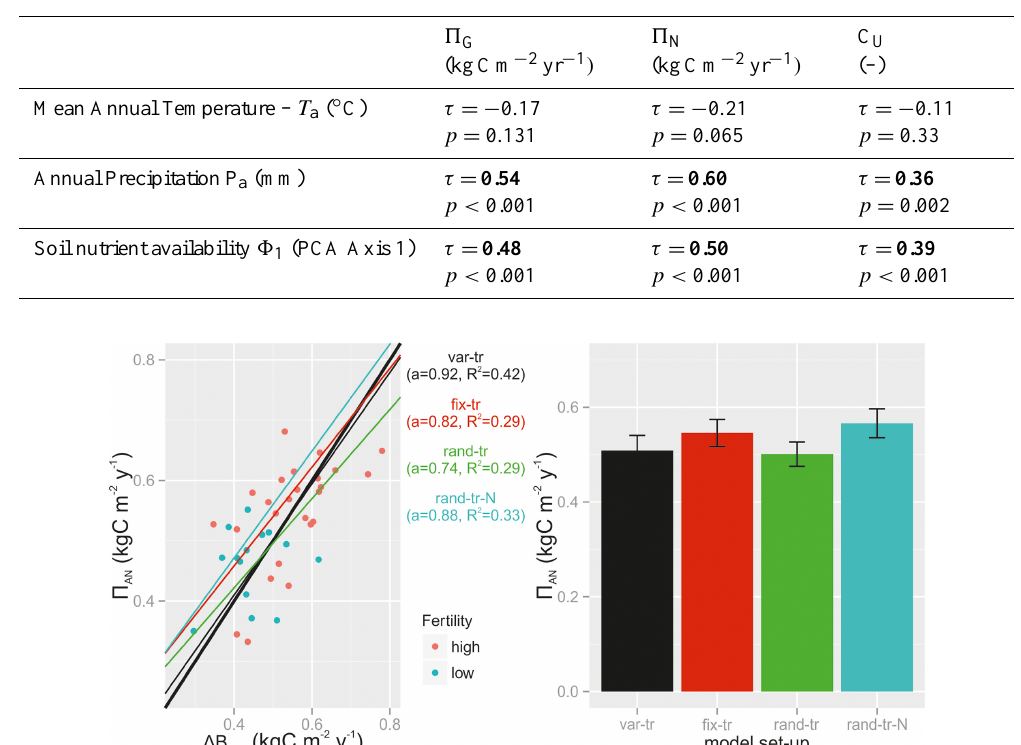
Table 1. Kendall correlation coefficients ( τ) and associated significance levels ( p ) between simulated gross primary productivity ( 5 G ) , net primary productivity ( 5 N ) , carbon use efficiency (C U ) and key environmental factors. Significant associations are indicated with bold.